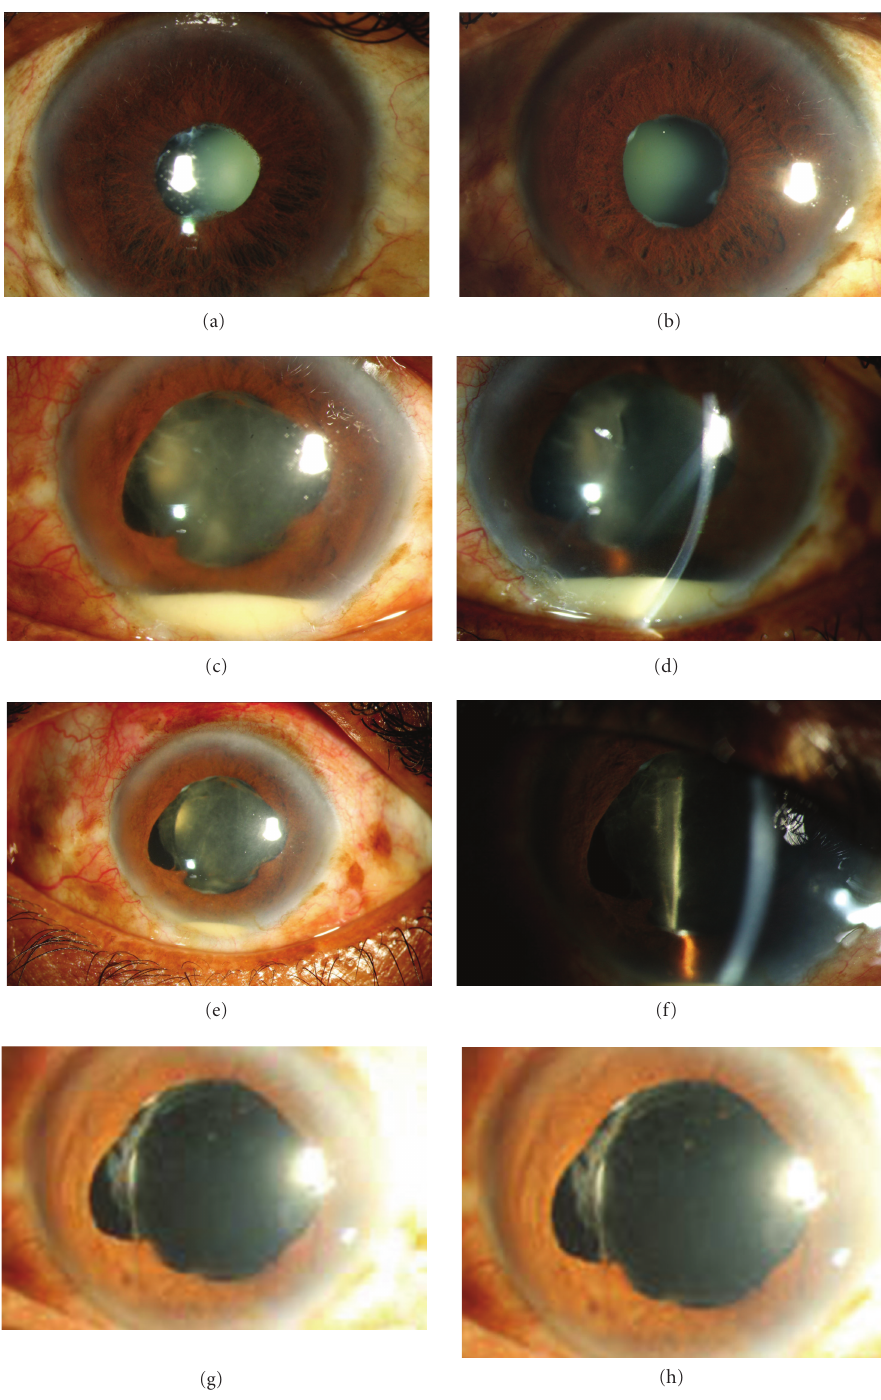
Figure 11: A 45-year-old man, a treated case of Hansen’s disease 15 years ago, presented with progressive visual loss. Examination showed active anterior uveitis and complicated cataract. He was treated with topical steroids and after 4 months, underwent phacoemulsification with PCIOL in the left eye. On the first postoperative day, his visual acuity improved to 20/50 (from preoperative vision of 20/200) with a mild fibrinous reaction in the anterior chamber. He returned to the emergency clinic on the next day with loss of vision and showed severe anterior chamber reaction with hypopyon. Vitreous appeared uninvolved. He was hospitalized and treated with intensive topical steroids and cycloplegics. He improved over the course of one week and regained good vision at the end of one month. (a, b) show the right and left eye with quiet anterior chambers and nondilating pupil with posterior synechia. (c, d) Di ff use and slit view of the left eye on the second postoperative day shows hypopyon and coagulum around the IOL. (e, f, g) Di ff use low and high magnification and slit view of the left eye two days after intensive treatment showing decrease in the inflammation. (h) The left eye shows near-quiet anterior chamber 2 weeks after treatment, the visual acuity has improved to